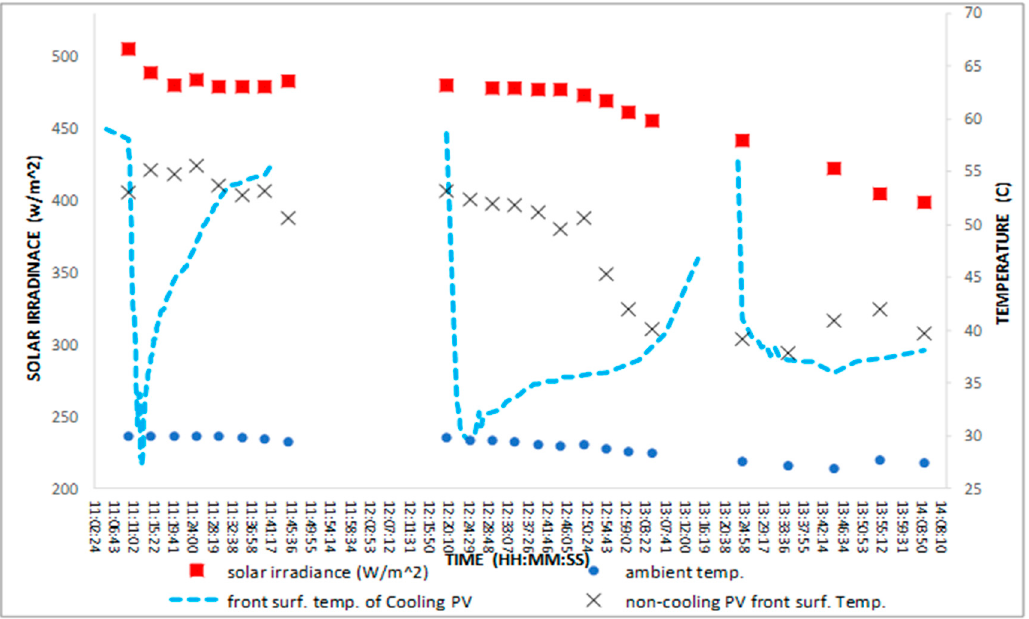
Figure 4. Solar Irradiance, ambient temperature, and temperature of the cooled and non-cooled panel vs. time.